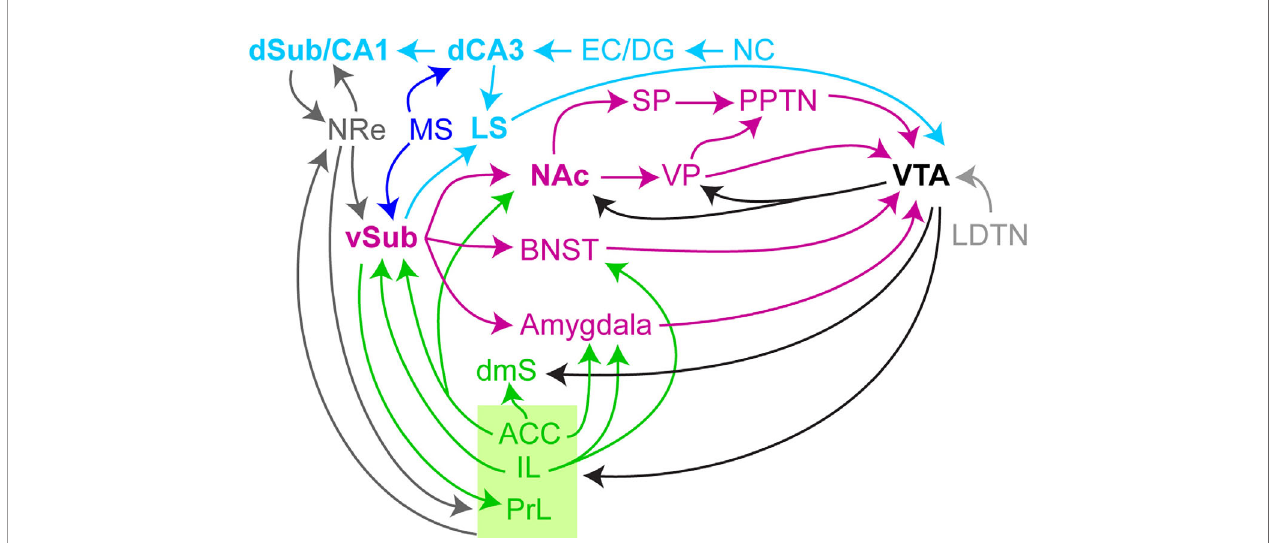
FIGURE 3 | Dorsal hippocampal and septal projections that regulate dopamine neuron activity. Extension of Figure 2 , additionally showing prominent connections from the dorsal CA3-sub fi eld ( dCA3 ), encoding contextual information from the neocortex ( NC ) transmitted through the entorhinal cortex ( EC ) and dentate gyrus ( DG ), to the lateral septum ( LS ). A further link between the dCA3 and the vSub circuit is mediated via dorsal CA1 ( dCA1 ) and the nucleus reuniens ( NRe